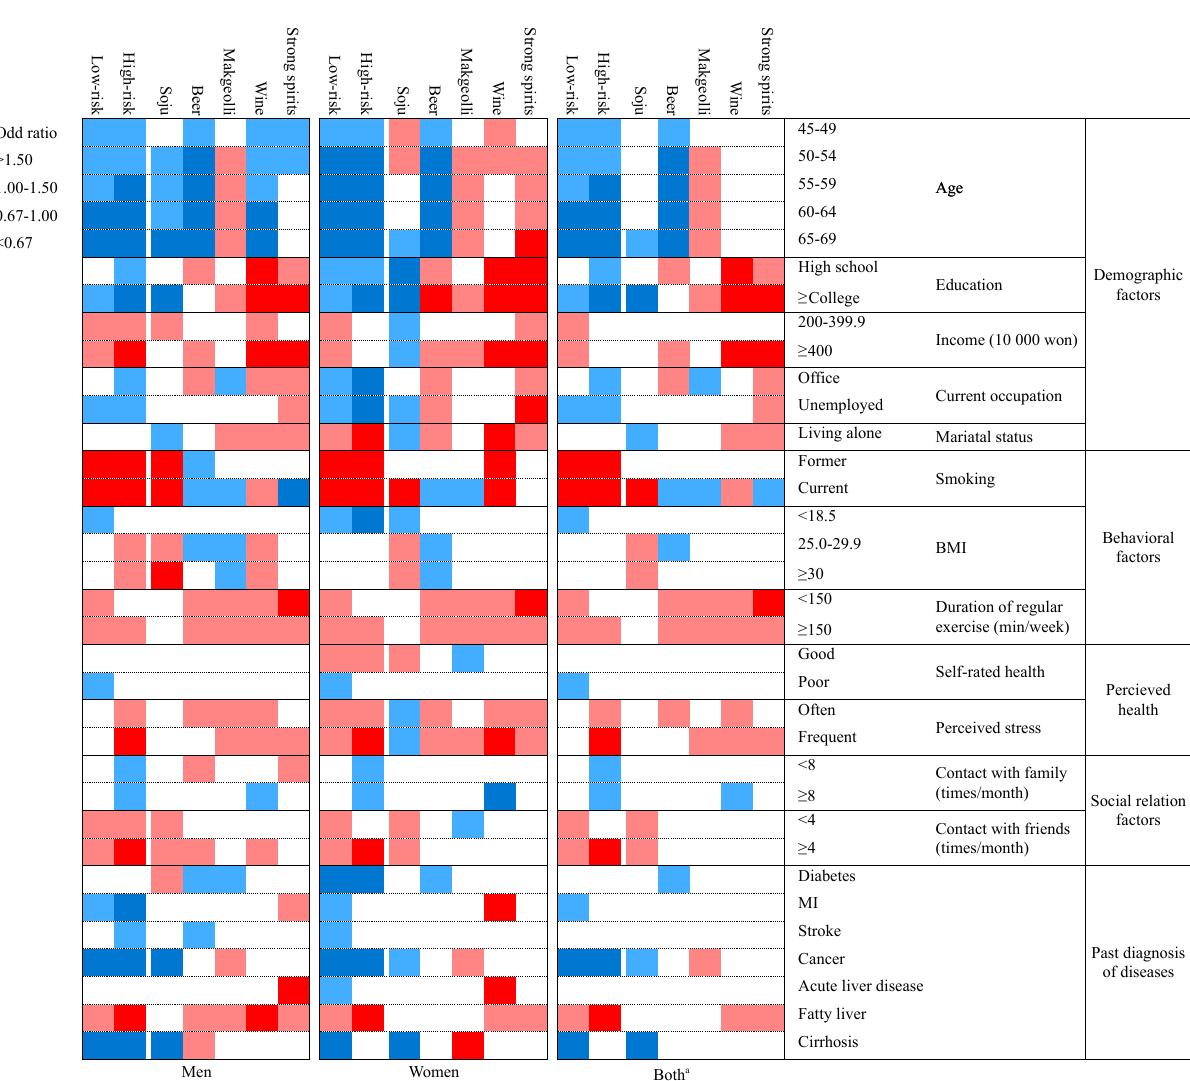
Odd ratios with adjustment were only considered and null associations were not highlighted a Those associations with same direction in both men and women were highlighted. Vibrant color is filled when odds ratios were more than 1.50 or less than 0.67 in both men and women Figure 3. Summary of associations of potential correlates with patterns of alcohol consumption including risk levels and types of alcoholic